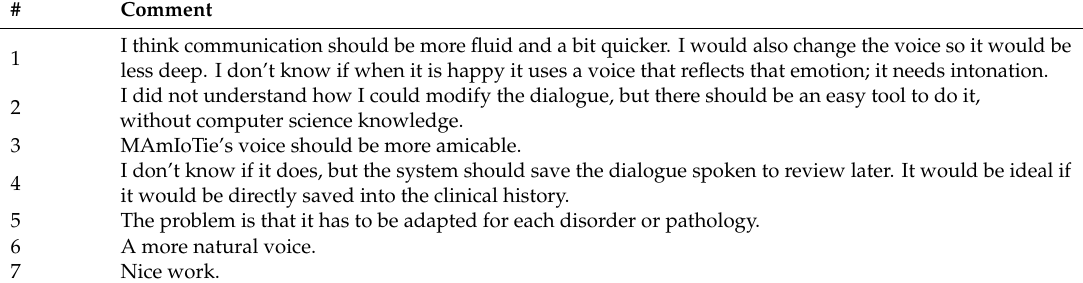
Table 8. Comments left on the questionnaire by the professionals to elaborate on matters not covered by the